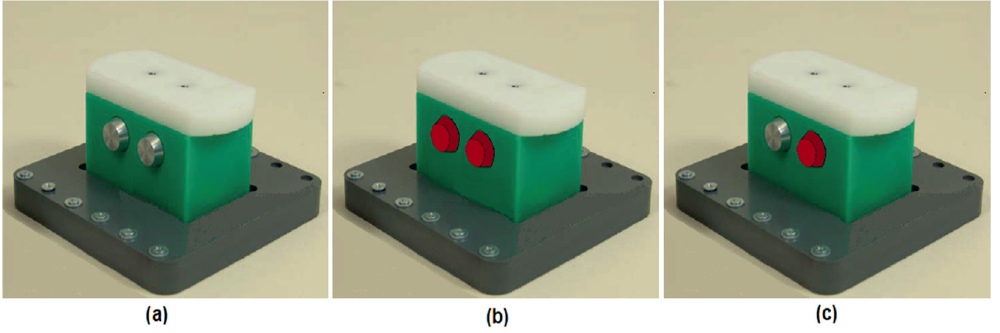
Figure 7. Assembled workpieces: ( a ) workpiece with metal cylinders; ( b ) workpiece with plastic cylinders and ( c ) workpiece with different cylinders.